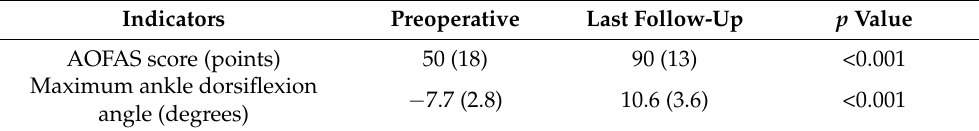
Table 2. The outcomes of AOFAS scores and maximum ankle dorsiflexion angles in the endo- scopic group.